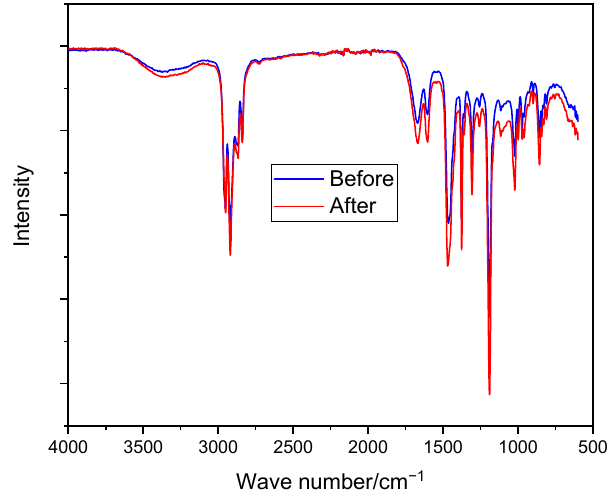
Figure 5. FTIR spectroscopy of PPO-3.45 + 3501 before and after immersion in 6 M KOH at room temperature for 10 days.